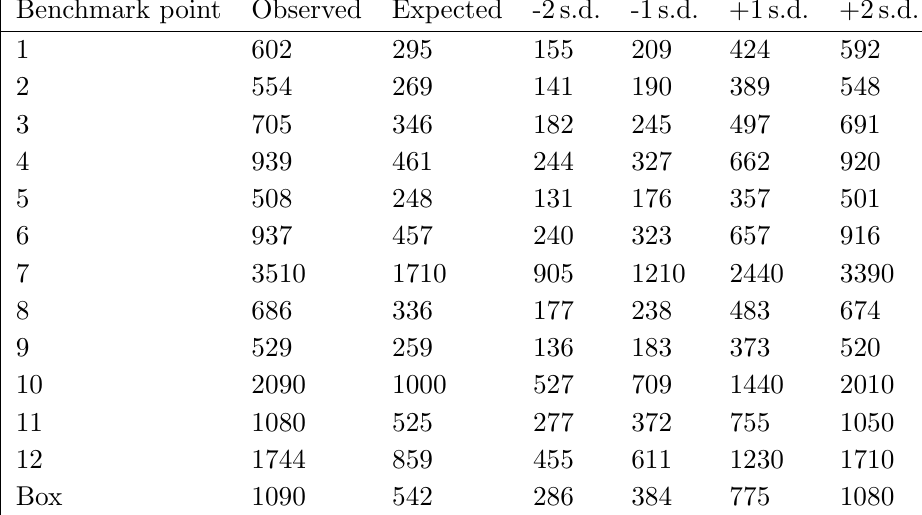
Table 6 . The observed and expected upper limits on the (cid:27) (pp ! HH ! bbbb) cross section for the 13 BSM benchmark models at 95% CL in units of fb.